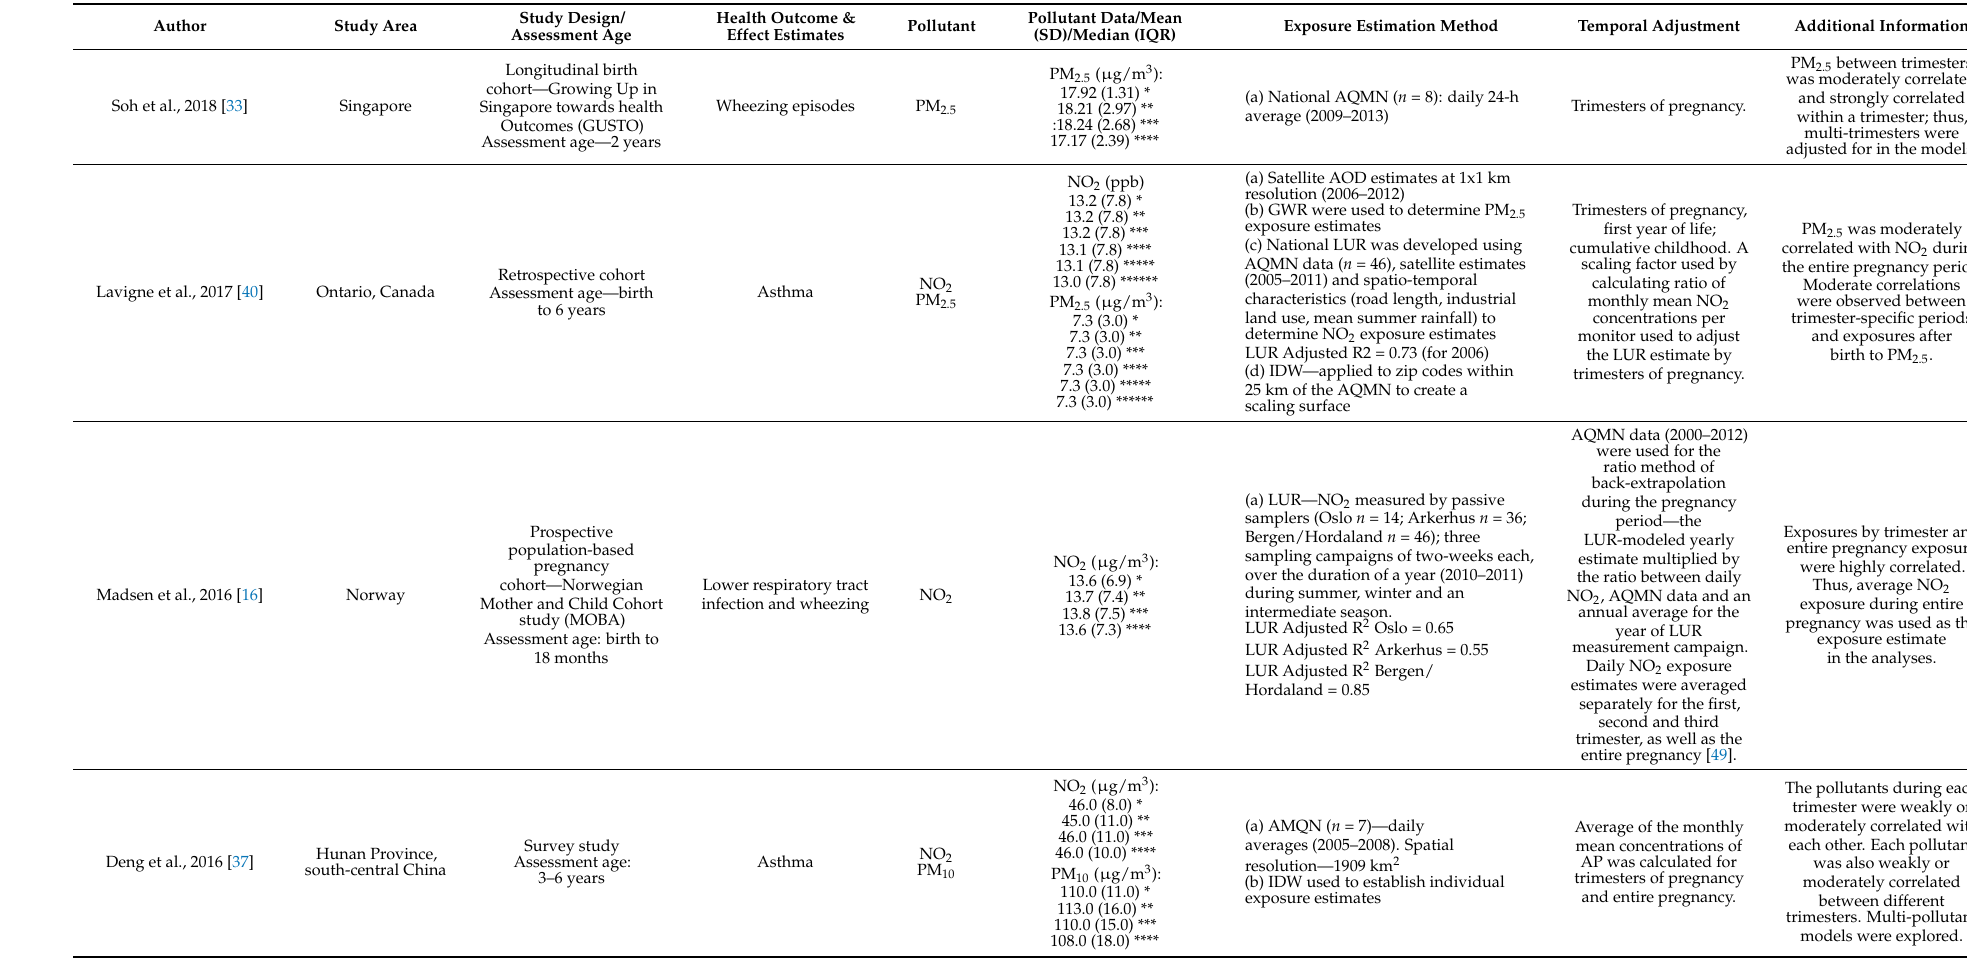
Table 1. Detailed Summary of Studies